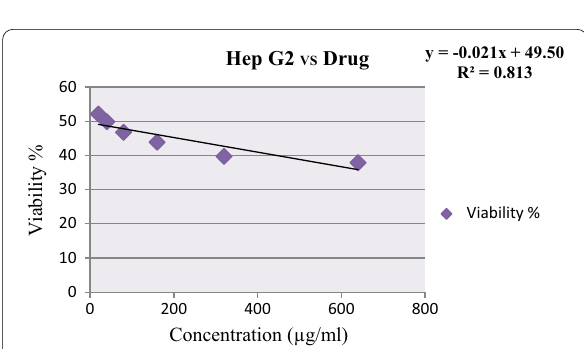
y = -0.021x + 49.50 R² = 0.813